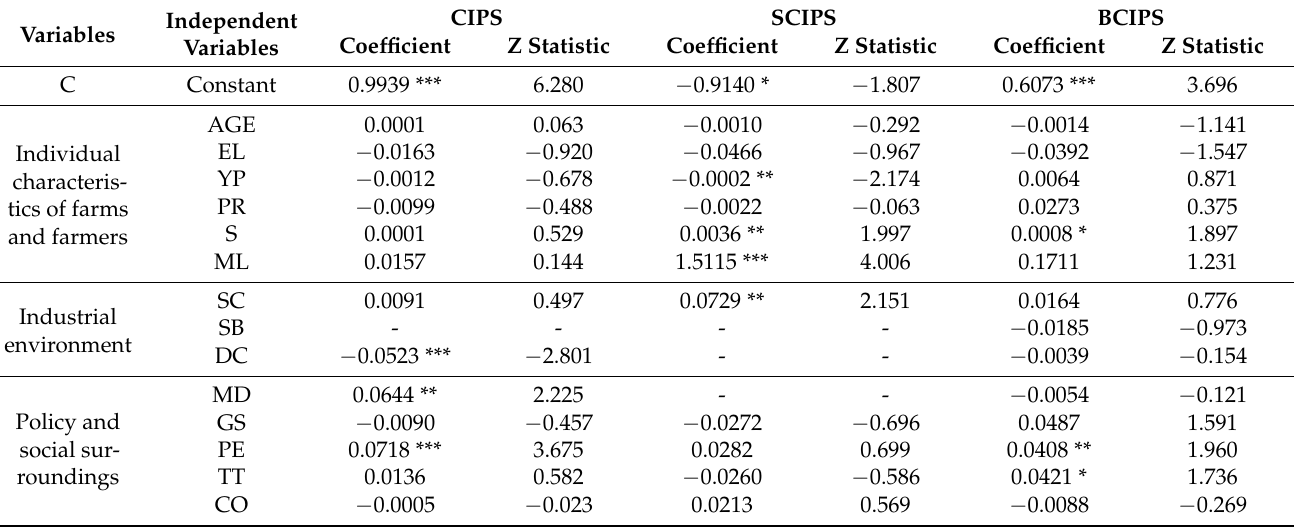
Table 8. Estimation Results of the Factors Influencing the Scale Efficiency (SE) of Different Beef Calf Production